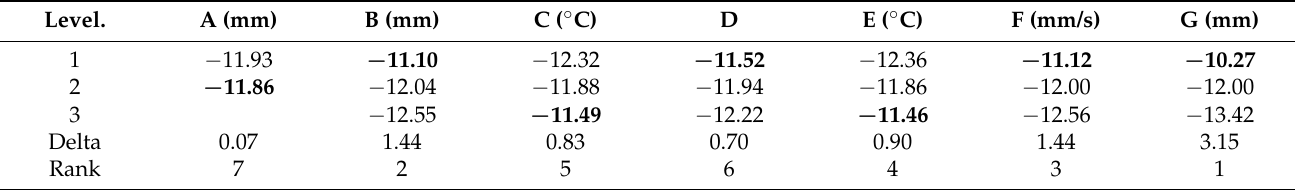
Table A2. Mean S/N ratio response table for Rq-ABS